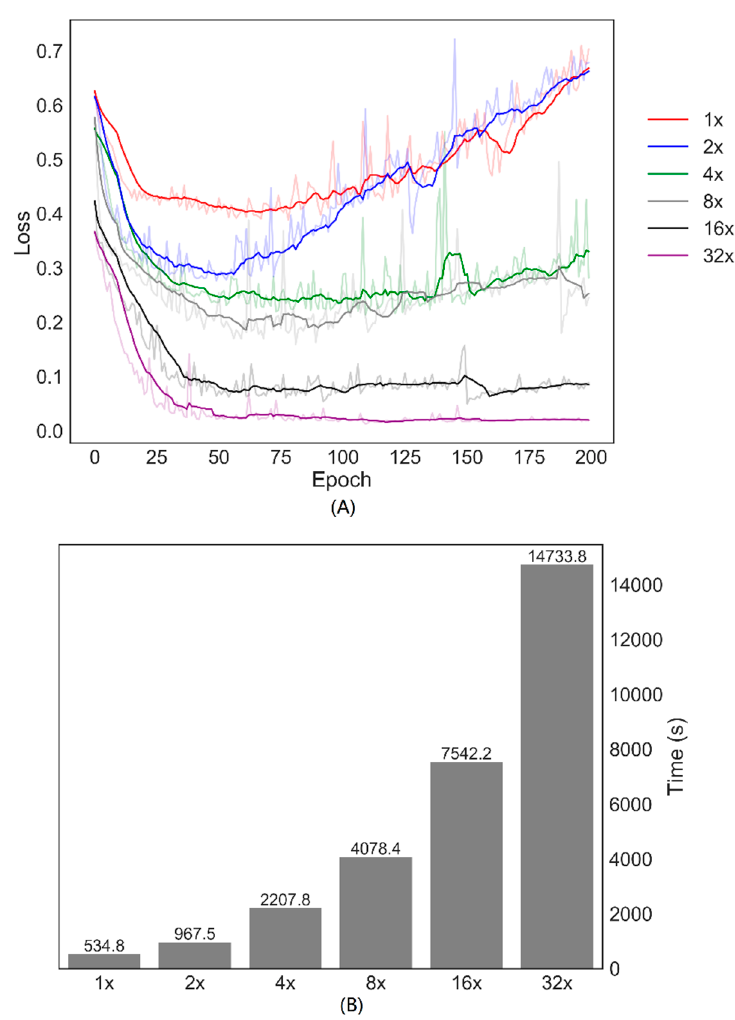
Figure 4. Performance of dataset augmentation. ( A ) Loss curves. ( B ) Time consumption for training the model.